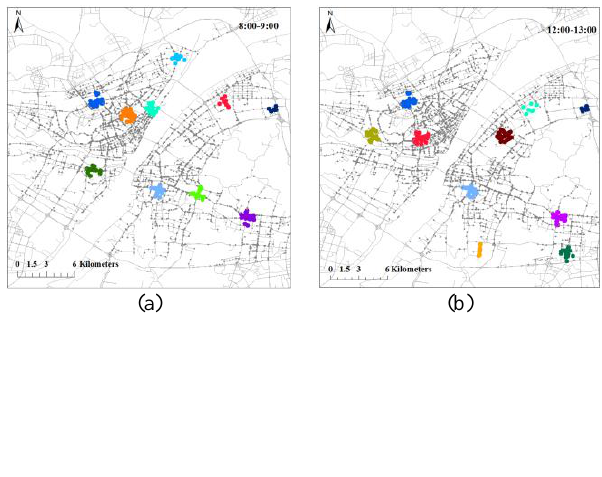
Figure 4. Hotspots on holiday (May 1 st ,